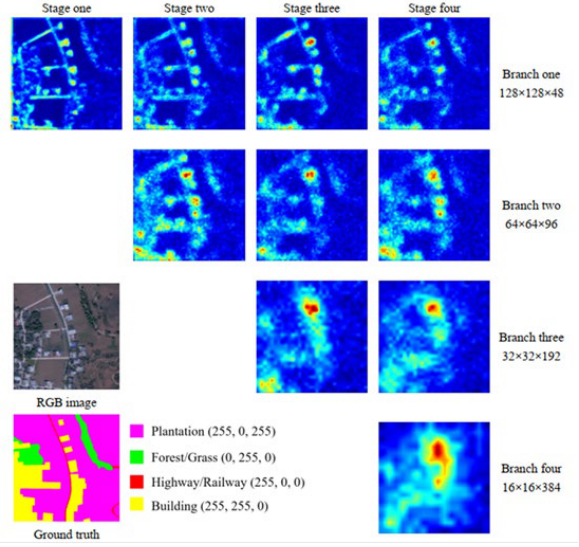
Figure 2. Example for feature map visualizations in HRNet (Fig. 1). Each of them is from the last feature map of the corresponding stage and branch, and up-sampled to the same size as the input image (i.e., 512×512).